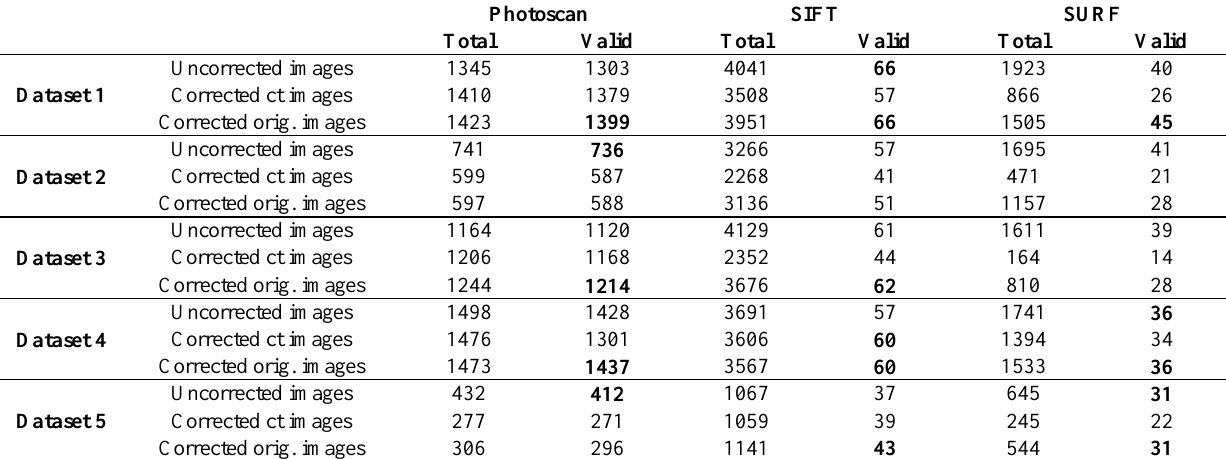
Table 1. The results of the matching process for all the datasets